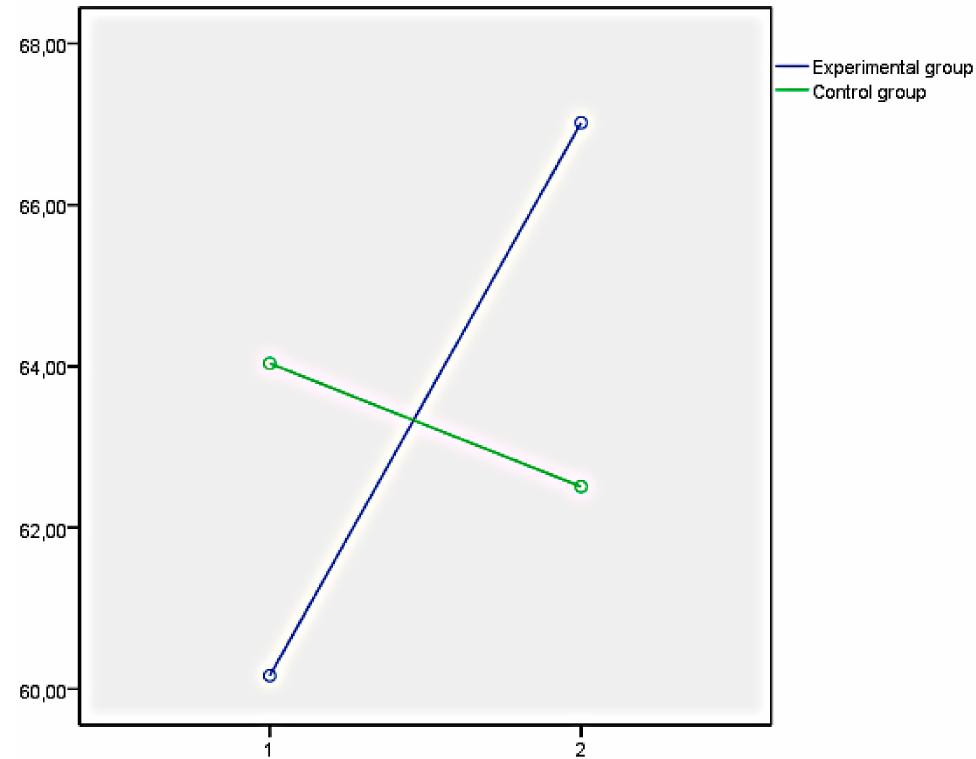
Figure 1. EQi total score as a representation of the significant differences obtained in a set of factors of EI measured with the Emotional Quotient Inventory Youth Version (EQi:YV).